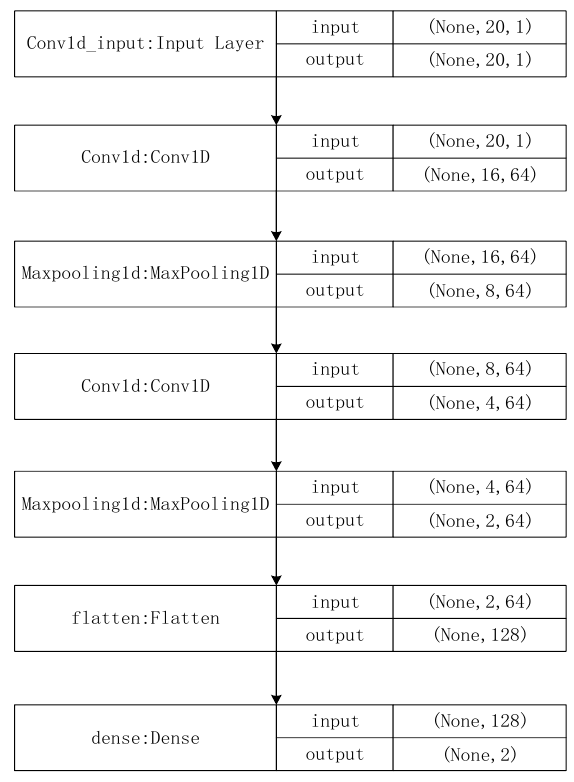
Figure 5. Model structure information of Model C.